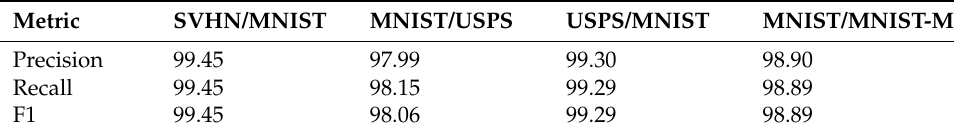
Table 7. Analysis of the proposed method with other evaluation criteria.